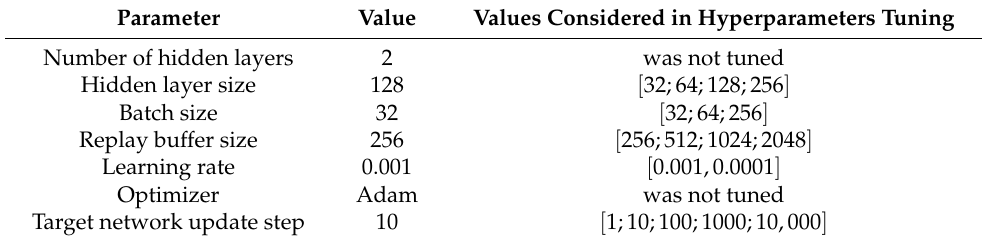
Table 1. The chosen hyperparameters after the DQN tuning.